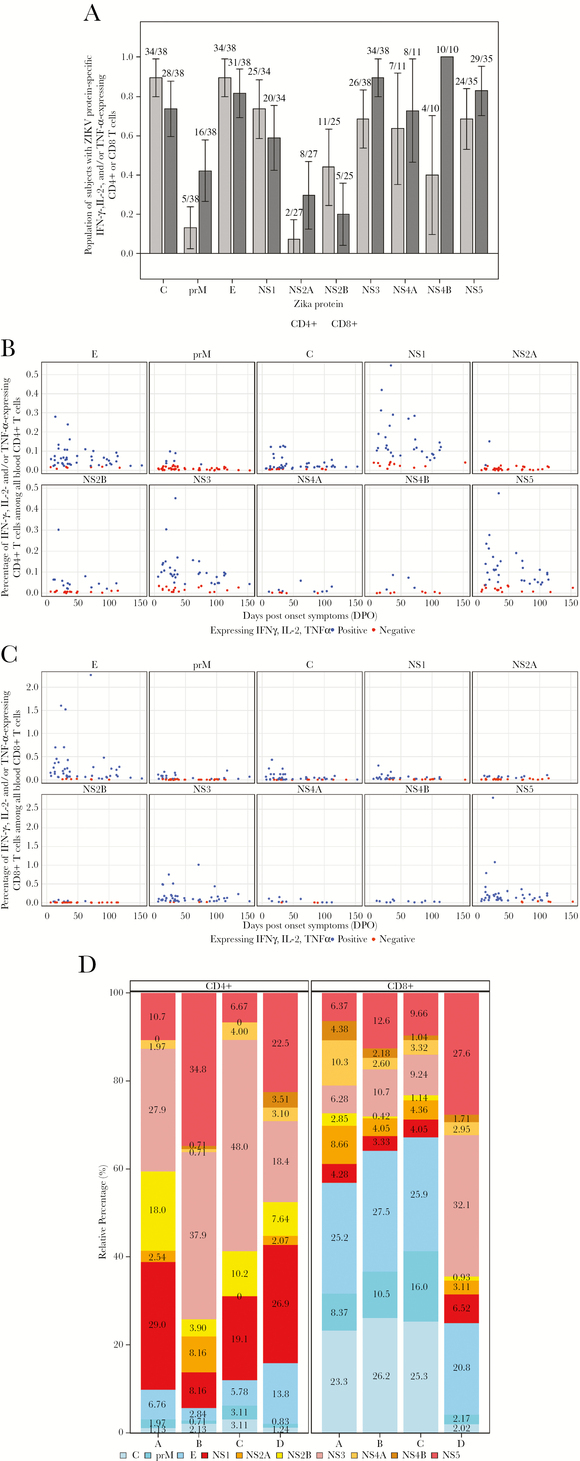
Zika virus (ZIKV)–specific CD4+ and CD8+ T cells producing interferon (IFN)-γ, interleukin (IL)-2, and/or tumor necrosis factor (TNF)–α cytokines after peptide stimulation in vitro. All 50 peripheral blood mononuclear cell (PBMC) samples (from 38 individuals) were tested against the structural proteins (E, C, and prM) and NS3; only 46, 42, 33, 31, 13, and 12 samples had sufficient PBMCs for testing against NS5, NS1, NS2a, NS2b, NS4a, and NS4B, respectively (Supplementary Data). A, Proportions of individuals with cytokine-expressing CD4+ T cells or CD8+ T cells against each ZIKV protein. PBMCs were analyzed in an intracellular cytokine staining assay for antigen-specific production of IFNγ, IL-2, and/or TNFα. Y-axis, proportion of subjects making a response against each of the 10 ZIKV proteins. The rank order for proportion of individuals with positive CD4+ T-cell responses was E, C, NS1, NS3, NS5, NS4A, NS2B, NS4B, prM, and NS2A, with percentages of tested subjects responding of 86%, 78%, 69%, 66%, 65%, 62%, 44%, 33%, 12%, and 6%, respectively. The rank order for proportion of individuals with positive CD8+ T-cell responses was NS4B, NS3, NS5, E, NS4A, C, NS1, prM, NS2A, and NS2B, with percentages of 100%, 92%, 87%, 86%, 77%, 76%, 67%, 48%, 33%, and 23%, respectively. B, Magnitudes for ZIKV protein–specific CD4+ T-cell or CD8+ T-cell responses. Total cytokine responses (IFN-γ, IL-2, and/or TNF-α expression) for each of the 10 ZIKV proteins over time are shown. Blue dots, positive responses; red dots, negative responses. X-axis, days post onset of symptoms (DPO). Y-axis, percent cytokine-producing cells among all blood CD4+ or CD8+ T cells. NS1, NS5, and NS3 (with geometric mean [GM] values of 0.14%, 0.10%, and 0.094% of total CD4+ T cells, respectively) had the highest magnitudes, compared with structural proteins E and C (GM values at 0.055% and 0.054%, respectively) and NS2B, NS4B, prM, and NS4A proteins (GM values at 0.047%, 0.040%, 0.025%, and 0.018%, respectively). CD8+ T-cell magnitudes were generally higher than for CD4+ T cells (note the y-axis scale differences). C and D, Relative magnitudes among total cytokine response of 4 subjects’ ZIKV-specific CD4+ T-cell and CD8+ T-cell responses against each of the 10 ZIKV proteins. For the 4 subjects whose samples were tested against all 10 ZIKV proteins, the relative proportions of their total response magnitude that were targeted to each individual structural (C, prM, E) or nonstructural (NS1, NS2A, NS2B, NS3, NS4A, NS4B, NS5) protein are shown. The time points analyzed for subjects A, B, C, and D were 16, 27, 39, and 62, respectively.